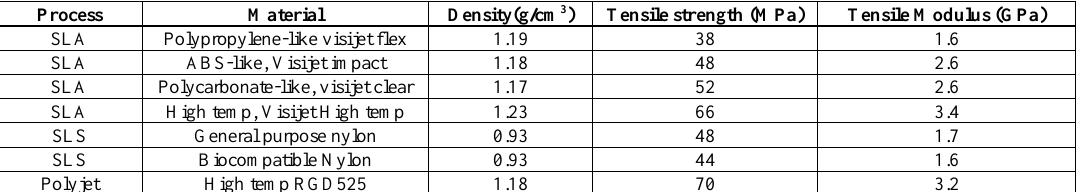
Table 2. Overview of some polymer mechanical properties produced by